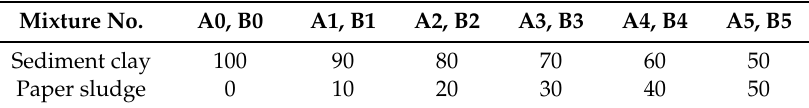
Table 1. Mixtures of paper sludge lightweight aggregates (weight